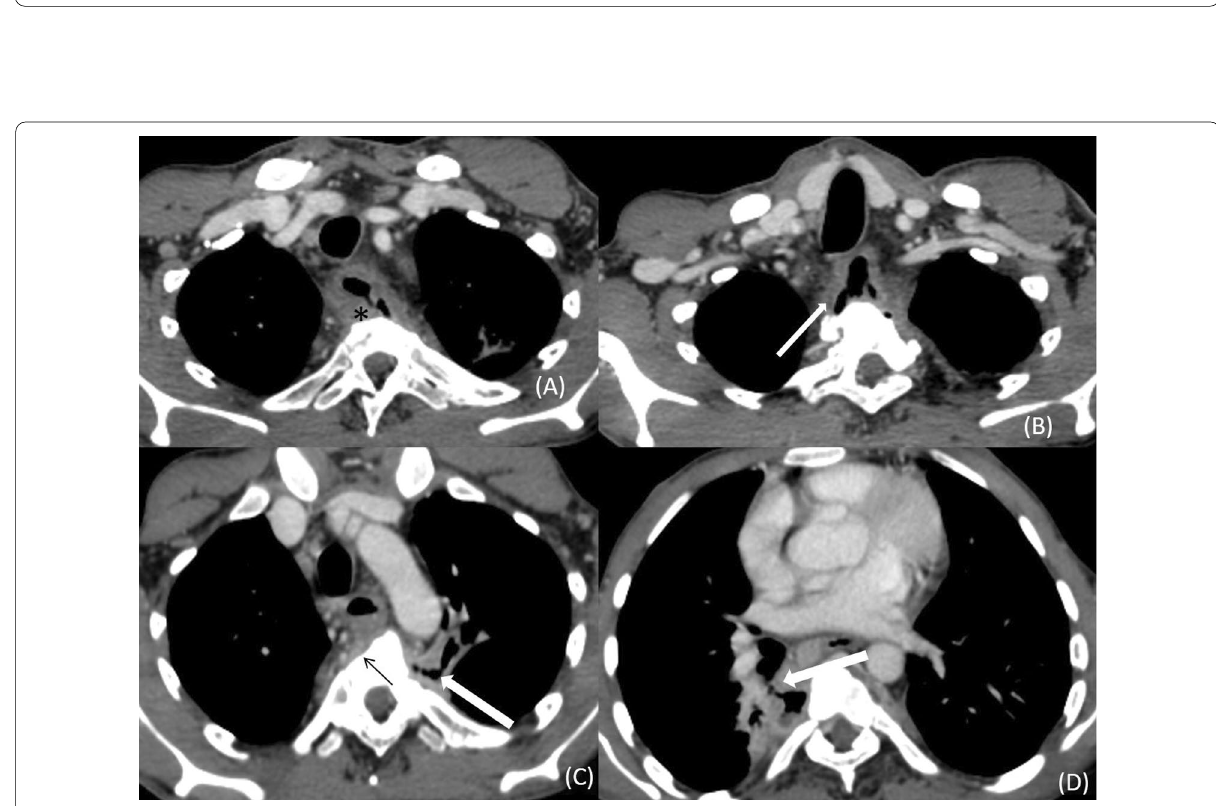
Fig. 20 Tuberculous paraspinal abscess with fistulous communication between oesophagus and bronchi. CT images of a 25-year-old male show a paraspinal abscess (* in A ) involving multiple vertebral segments, air foci are seen within the abscess at multiple levels ( B – D ) with vertebral body irregularity and scalloping (black arrow in C ), fistulous communication is seen between the paraspinal abscess and cervical oesophagus (white arrow in B ) and right and left segmental bronchi (white arrow in C , D